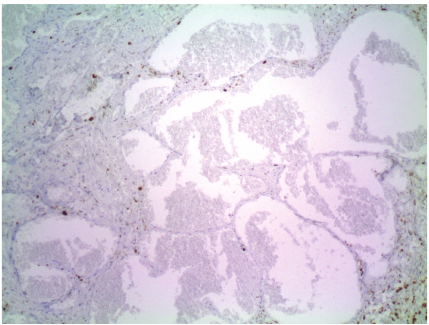
Figure 5: Cavernous hemangioma with virtually no Ki67